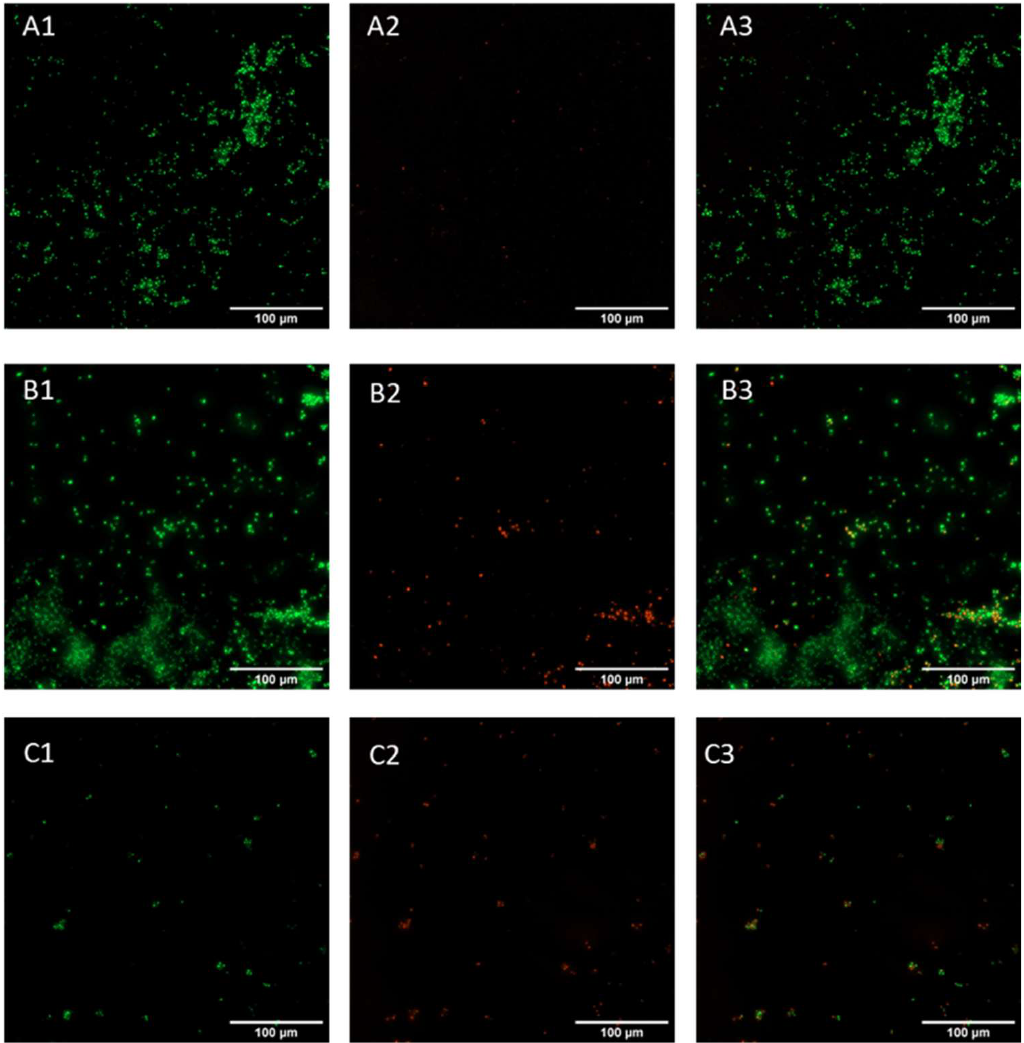
Figure 7. Live and dead representative fluorescent images of Candida biofilm grown on a plastic surface ( A ) and GO ( B ) and GO/CU ( C ) surfaces for 24 h. Live cells are stained green ( A1 – C1 ), and dead cells are stained red ( A2 – C2 ). Images were merged ( A3 – C3 ) with ImageJ Fiji software. Images were taken using the Cytation 5 Cell Imaging Multi-Mode Reader (Agilent, Santa Clara, CA, USA). The scale bar is 100 µm.